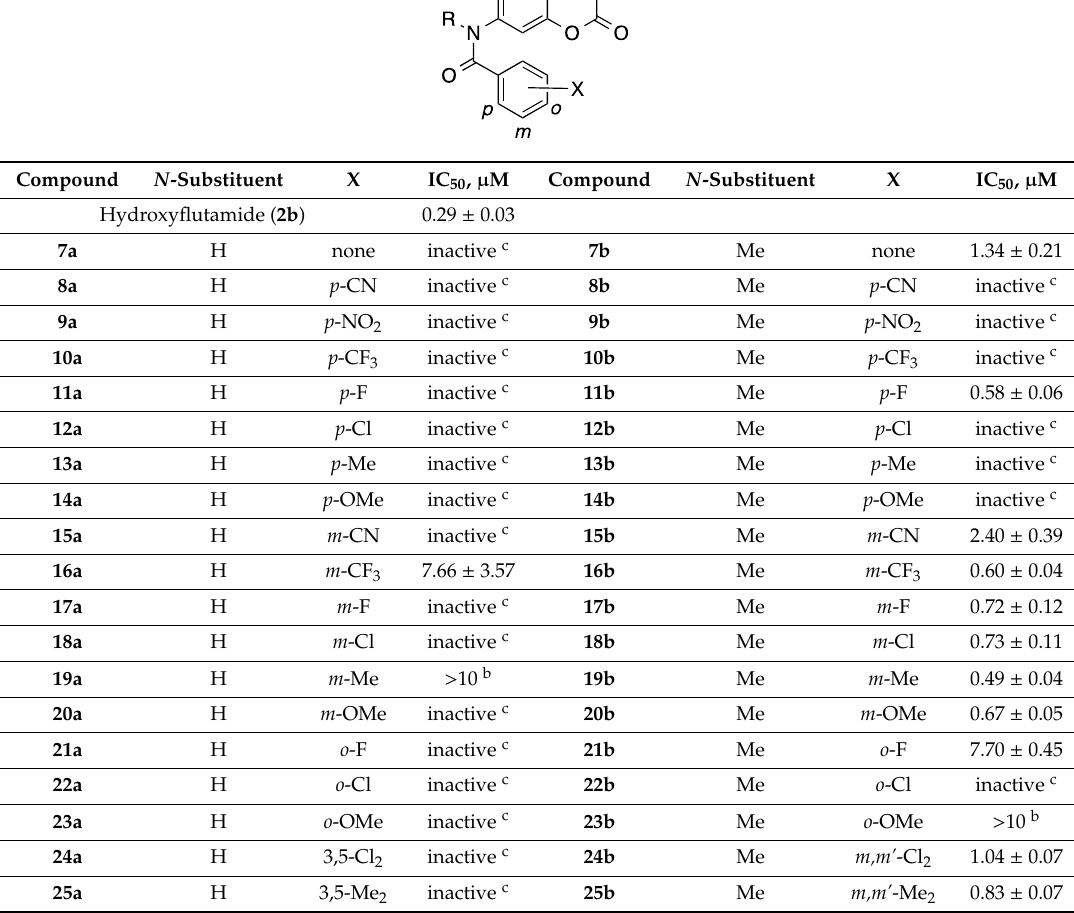
Table 1. AR-antagonistic activity of coumarinamide derivatives in SC-3 cell assay a .